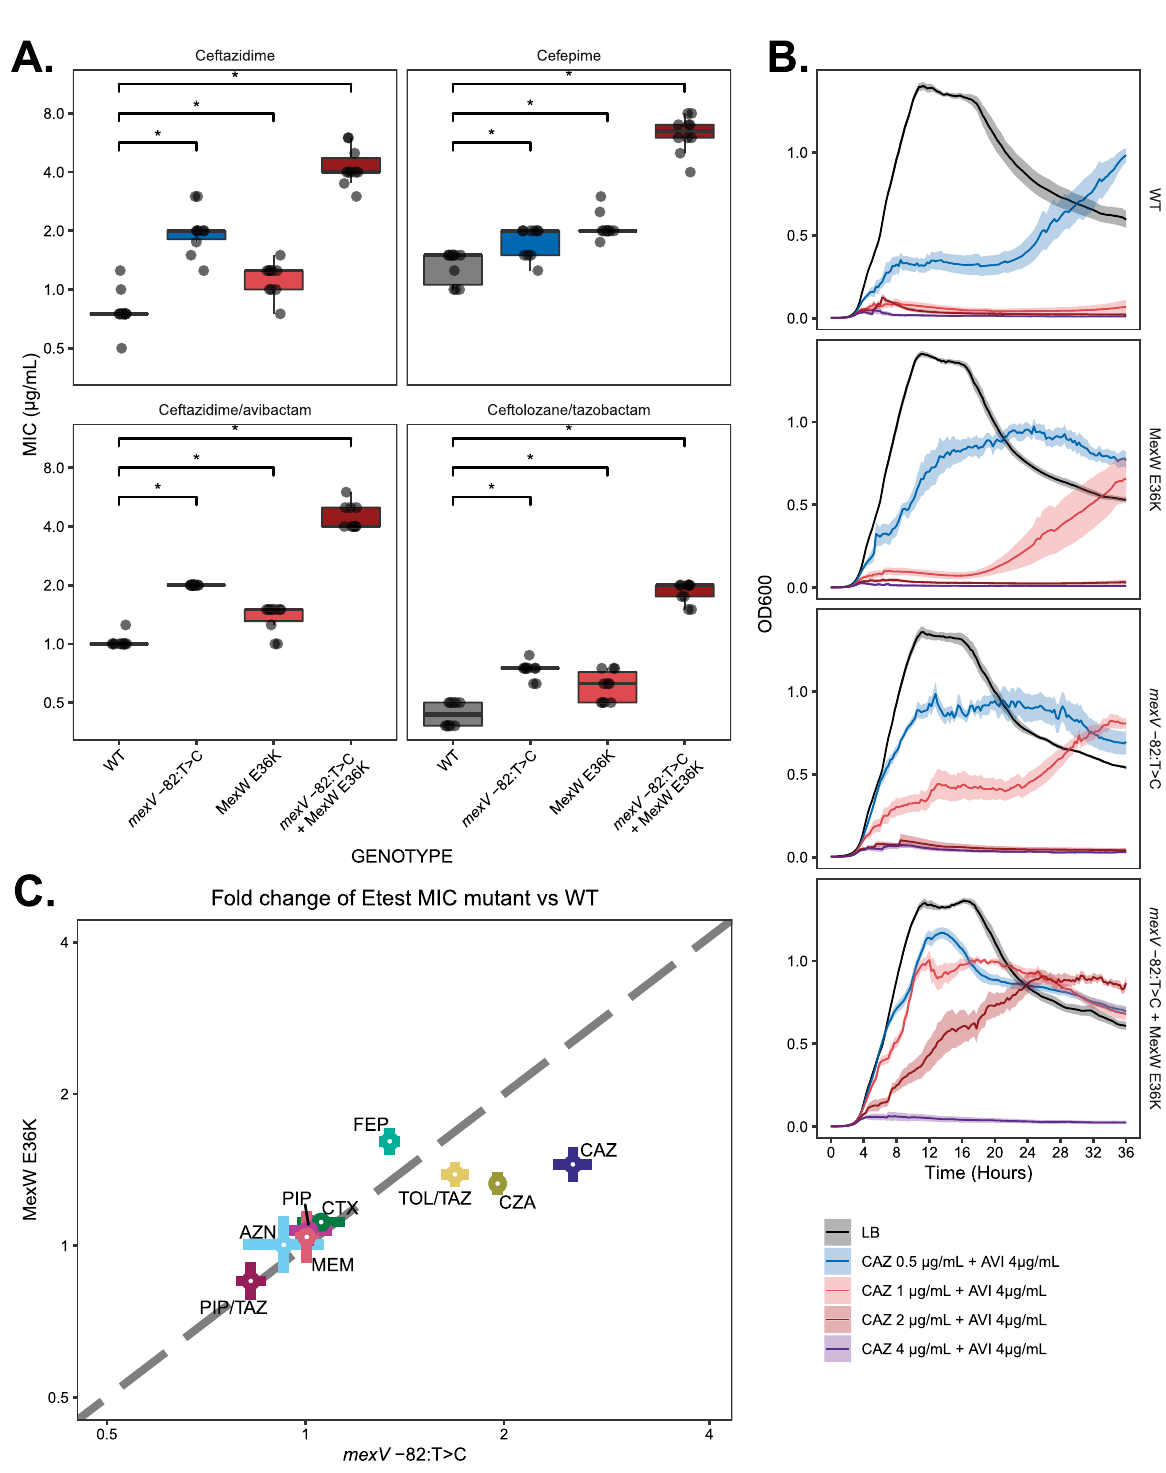
Fig 4. MexVW efflux pump mutations introduced into a WT MPAO1 strain confer resistance to cephalosporins and cephalosporin/beta- lactamase combination antibiotics. ( A ) Gradient diffusion (E-test) MICs for MPAO1-WT, mexV -82:T > C, MexW E36K, and double mutant ( n = 10 per antibiotic/genotype combination). The boxes display the median with the lower and upper hinges corresponding to the first and third quartiles. Brackets with asterisks above the plot indicate statistical significance with respect to MPAO1-WT (Wilcoxon 2-sided p -value < 0.05). All pairwise comparisons between mutants were statistically significant as well (S7 Table). ( B ) Growth curves of MexVW engineered strains at